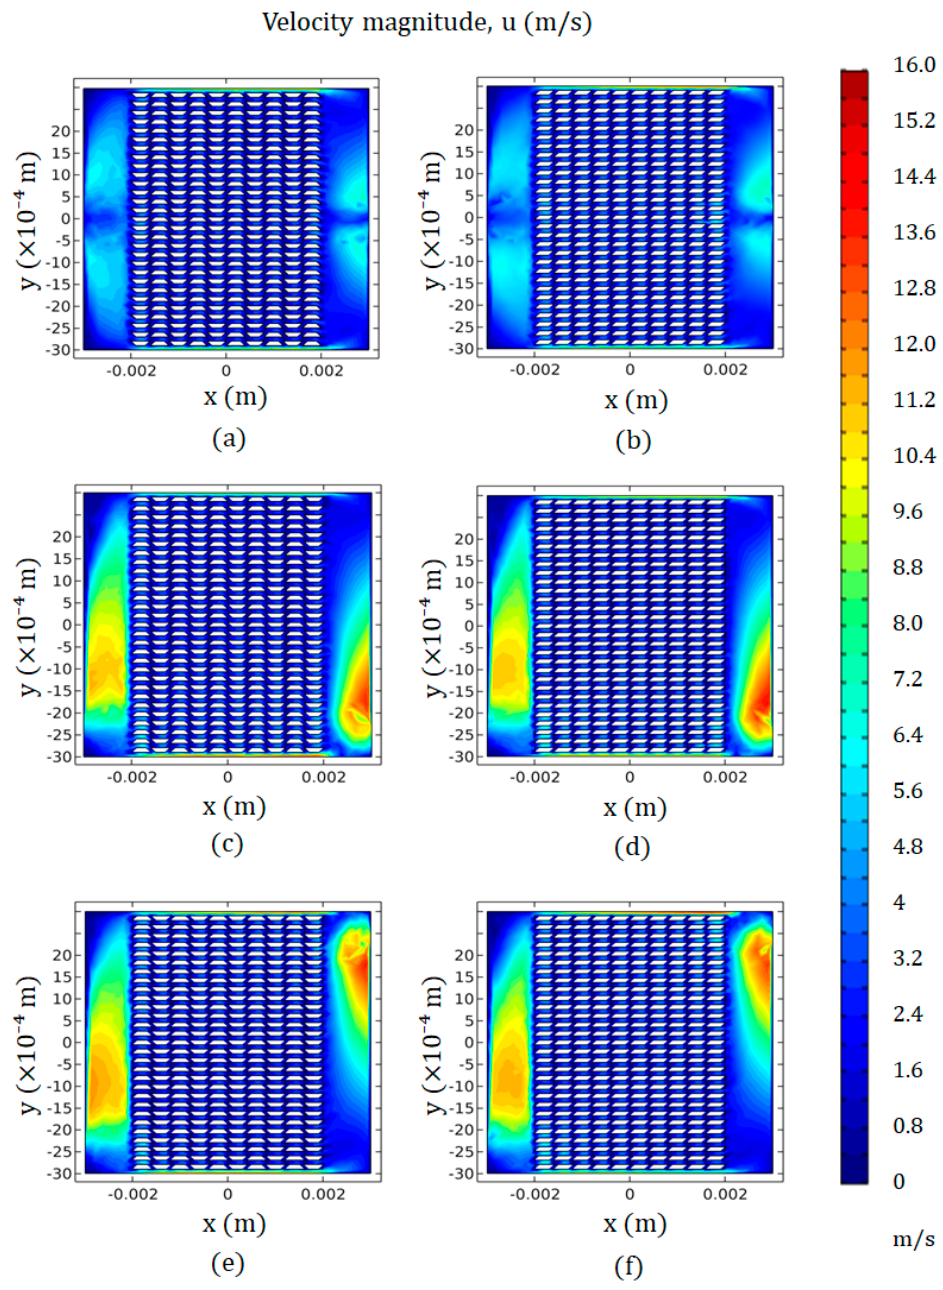
Figure 6. Contour plot of velocity magnitude at midplane (z = 0) of the heat sink at the volumetric flow rate of 4.0 × 10 − 6 m 3 / s for the ( a ) I-type regular trapezoidal secondary flow, ( b ) I-type parallel secondary flow, ( c ) C-type regular trapezoidal secondary flow, ( d ) C-type parallel secondary flow, ( e ) Z-type regular trapezoidal secondary flow, and ( f ) Z-type parallel secondary flow.